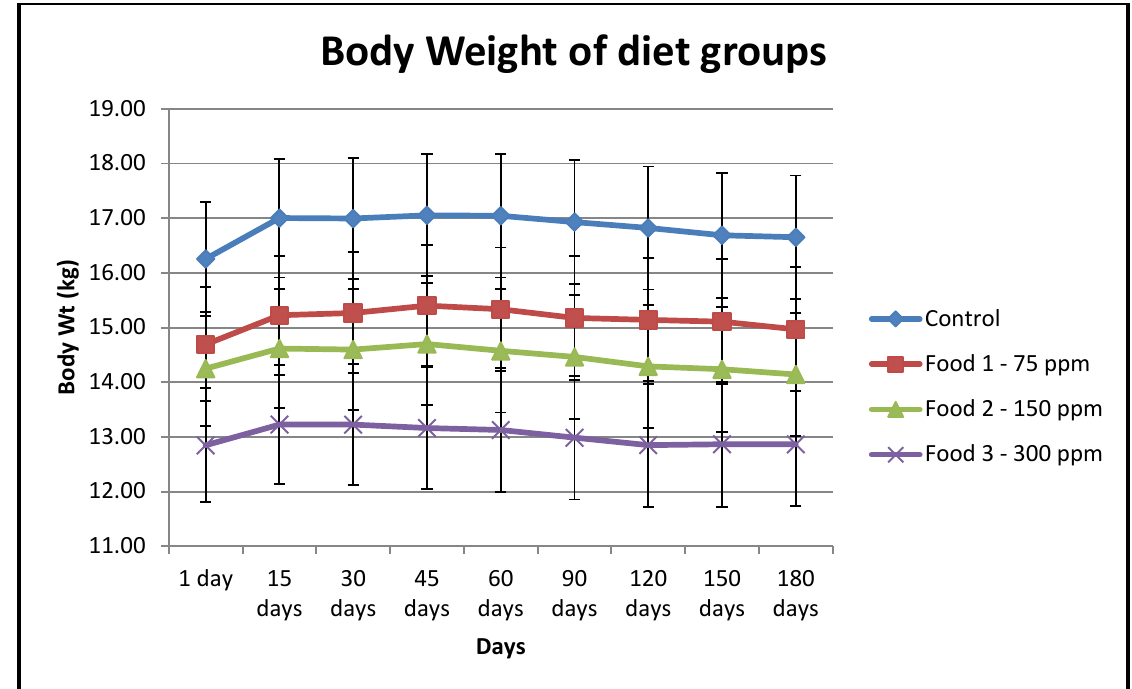
Figure A1. Bodyweights of animals in all food groups during the test phase of the study. Control, Food 1, Food 2 and Food 3 have 0 ppm, 75 ppm, 150 ppm and 300 ppm of a-LA respectively. Figure A2. Food offered to animals in all food groups during the test phase of the study. Control, Food 1, Food 2 and Food 3 have 0 ppm, 75 ppm, 150 ppm and 300 ppm of a-LA respectively. The amount of food offered was adjusted in response to weight gain at the end of weeks 2, 4, 6 and/or 8 and thereafter, on an individual basis, and accounts for decreased food offered to maintain body weight.